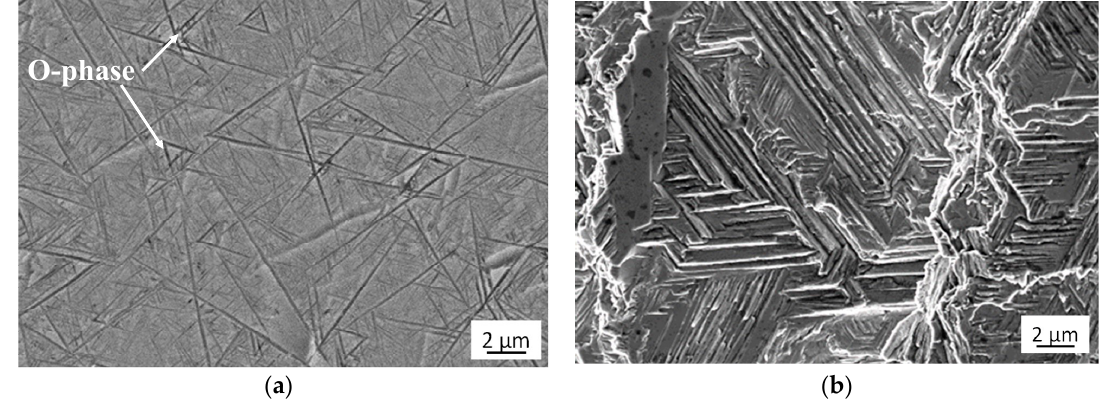
Figure 3. Structure ( a ) and fracture ( b ) of Ti–25Al–12.5Nb–6.01Mo–0.48V alloy.